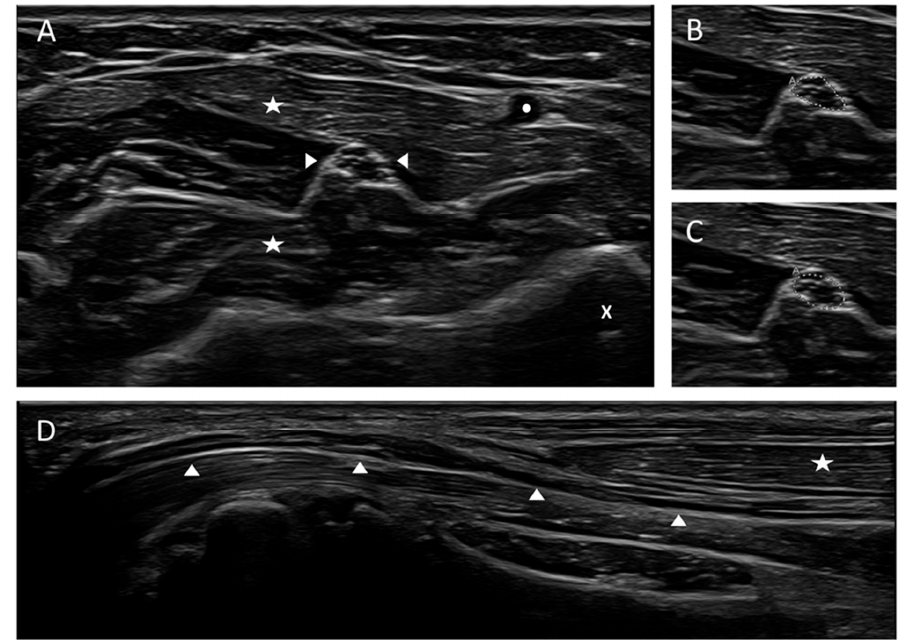
Figure 1. Cross-sectional and longitudinal view of a normal median nerve at forearm level. ( A ) Cross-sectional view of the median nerve. The nerve appearance is honey-comb-like with hypoechoic fascicles and hyperechoic epi- and perineurium. ( B , C ) Measurement techniques of the cross-sectional area (CSA) using the free-hand ( B , upper picture) or ellipse function ( C , lower picture) of the ultrasound device, CSA 5 mm 2 . ( D ) Longitudinal view of the median nerve in panoramic view. Left side of the picture: entrance into carpal tunnel. Arrow heads are marking the nerve, asterisks the superficial and flexor digitorum muscles, the circle the radial artery and the x the radial bone, “A” in pictures B and C means “area”.